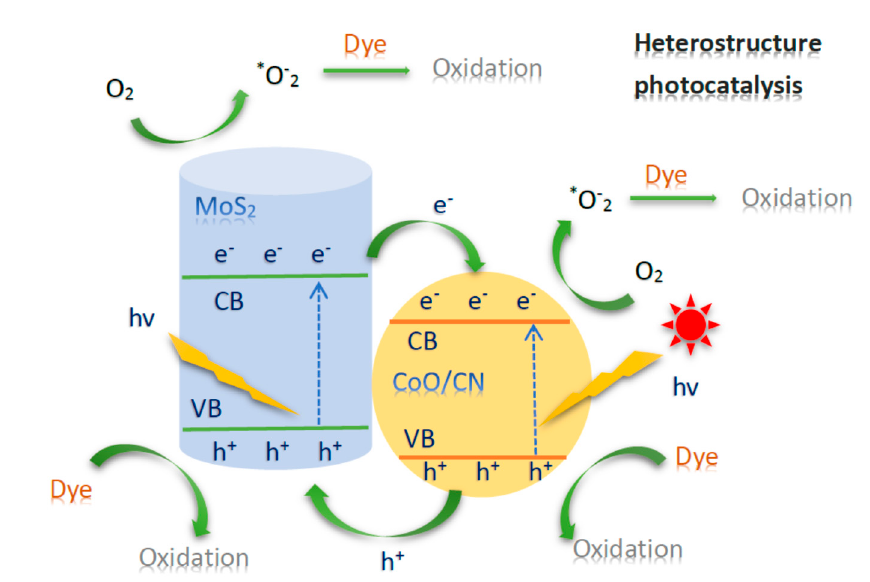
Figure 9. Schematic illustration and energy diagram of the charge transfer and photocatalytic redox